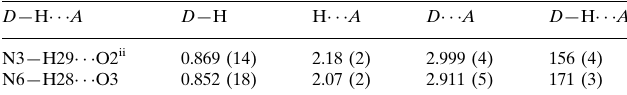
Hydrogen-bond geometry (A˚ , (cid:2)